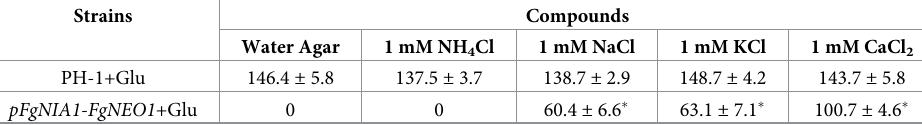
Each number indicates the ascospores discharged from 35 perithecia. ± SD was calculated from three independent experiments, and asterisks indicate statistically significant differences ( p <